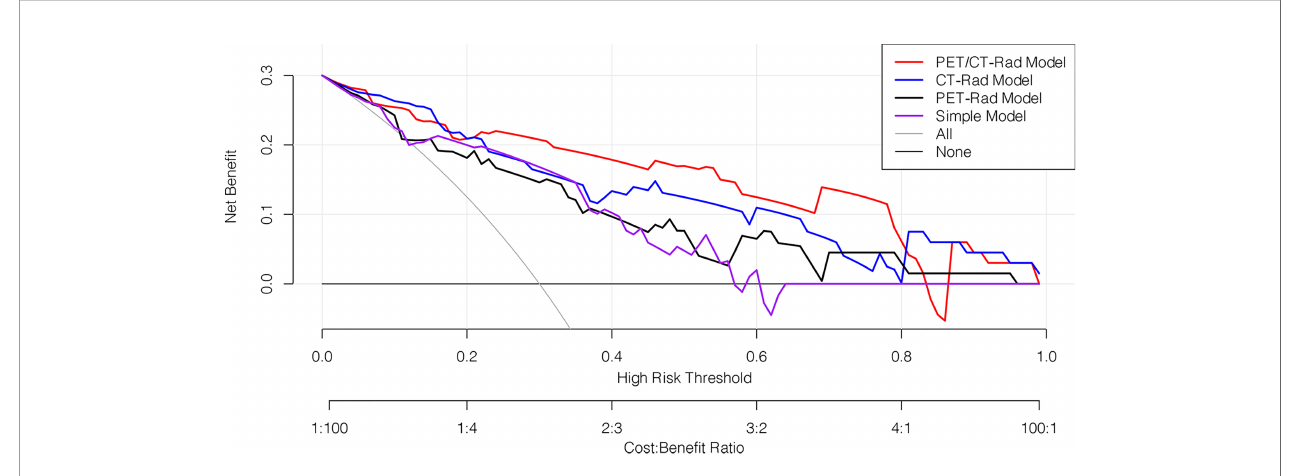
FIGURE 6 | Decision curve analysis of four predictive models. The horizontal axis represented the threshold probability where the expected bene fi t of treatment as IDH mutation was equal to the expected bene fi t of avoiding treatment as IDH wildtype. The vertical axis represented the net bene fi t for the treatment which considered the bene fi t of true positive and loss of false positive. The net bene fi t of all these four models is further compared with the default strategies, which we treat all patients as IDH mutation (grey line) or as IDH wildtype (black horizontal line). Results indicated PET/CT-Rad model have the most satisfactory clinical value.